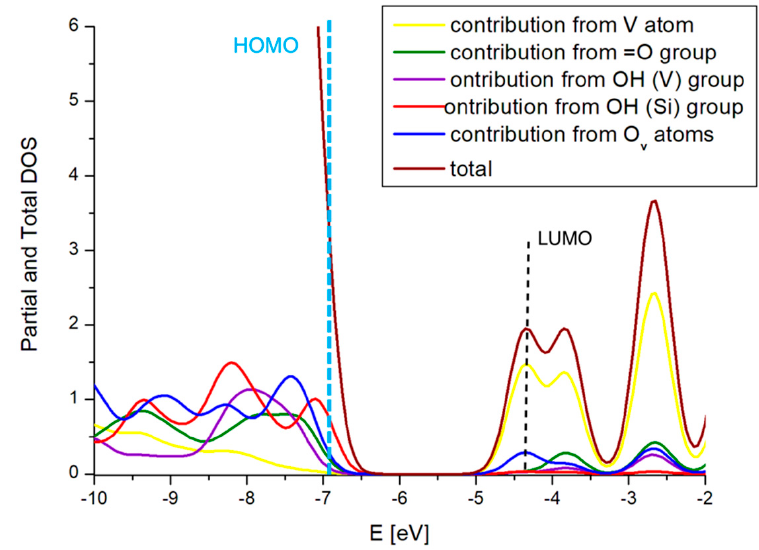
Figure 8. DOS plot of the V(=O)(–OH) center in the T3 position.